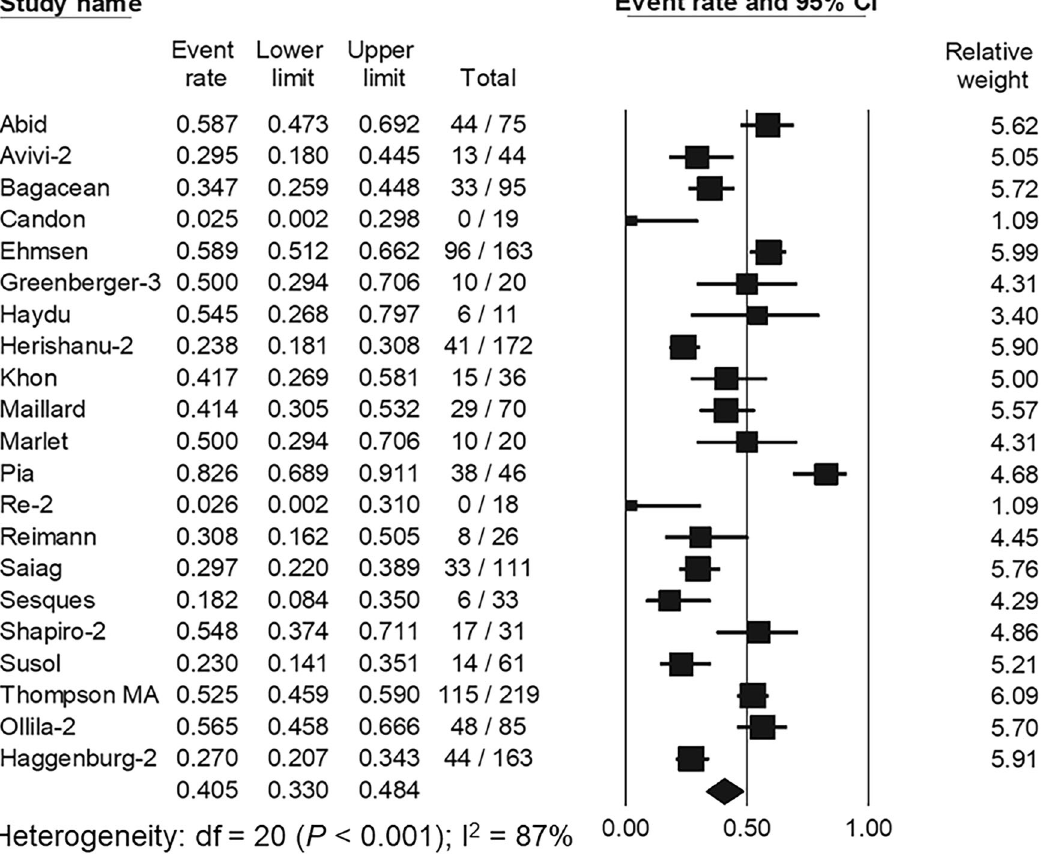
Fig. 3 The pooled seroconversion rate following SARS-CoV-2 booster vaccination in patients with hematologic malignancies. The pooled analysis of 21 studies containing 1518 patients with hematologic malignancies showed that the pooled seroconversion rate after booster vaccination was 40.5% (95% con fi dence interval [CI], 33.0 –